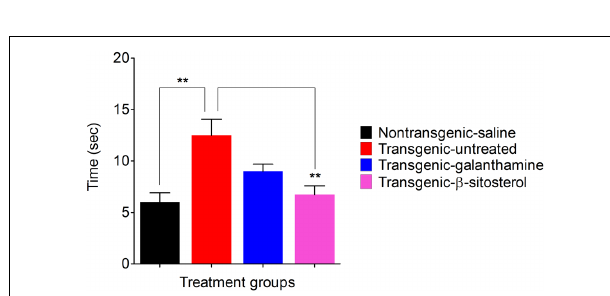
FIGURE 5 | Effect of β -sitosterol on motor coordination and balance in the balance beam test.